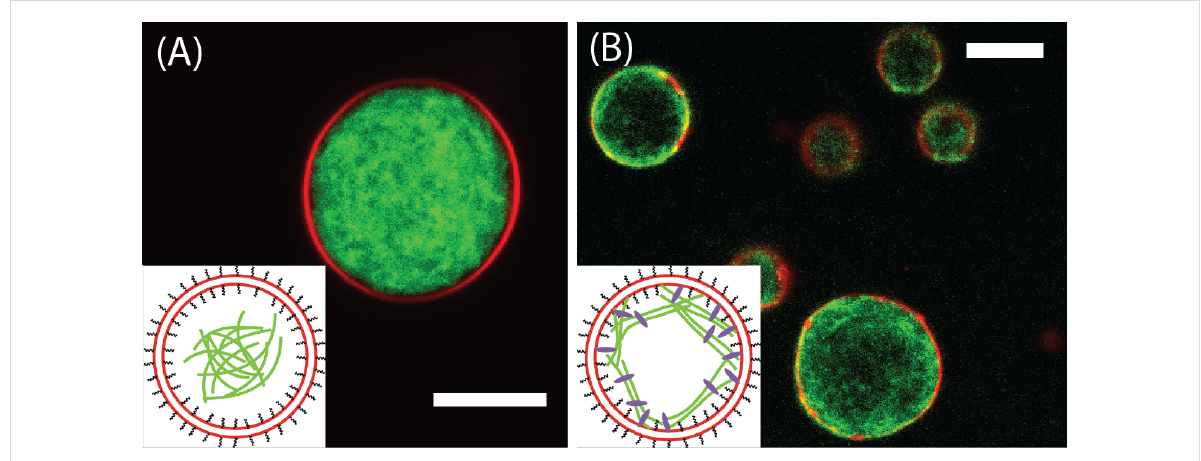
Figure 6: Confocal fluorescence micrographs of giant actin-filled liposomes. Lipid membranes are labelled with rhodamine (red); actin is labelled with AlexaFluor 488 (green). Insets indicate the nature of the actin-membrane interaction. (A) The actin filament solution inside a liposome with an inert membrane (containing PEG-lipids) is homogeneous and displays a depletion zone underneath the membrane. (B) Liposomes, which contain biotiny- lated lipids, encapsulate networks of biotinylated actin filaments that are coupled to the membrane via biotin–streptavidin bonds. The scale bars repre- sent 10 μ m. (Adapted with permission from [72]. Copyright (2011) American Chemical